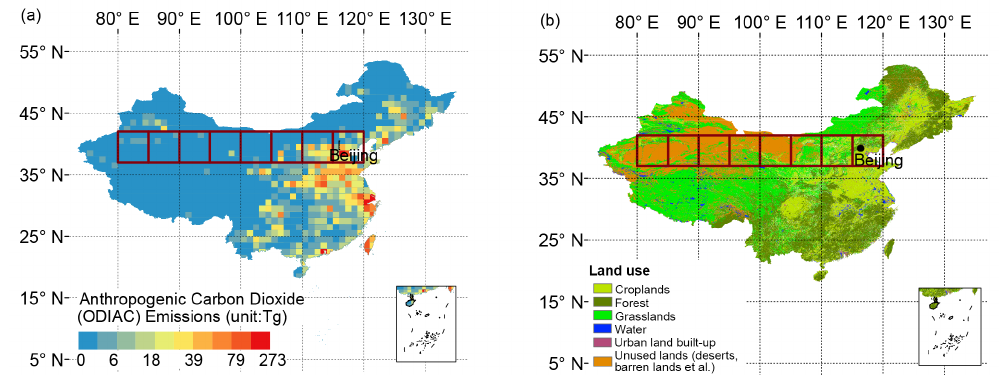
Figure 1. (a) Location of the study area in China segmented into cells (deep red cells) and annual fossil fuel CO 2 emission in 2012 (1 × 1 ◦ ) from ODIAC. (b) Land use map from 2010, where the black dot represents Beijing, the capital of China. Table 1. Summary of validating results with TCCON, data screening schemes, consideration in scattering and bias corrections for the four retrieval